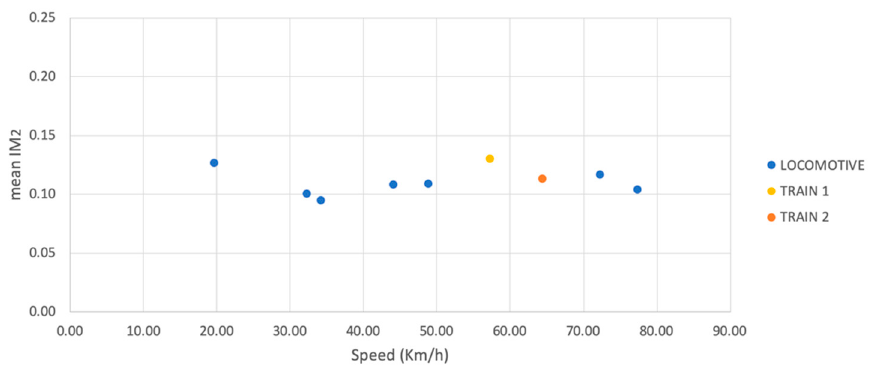
Figure 16. Mean IM 2 for each measurement point on the lower deck.